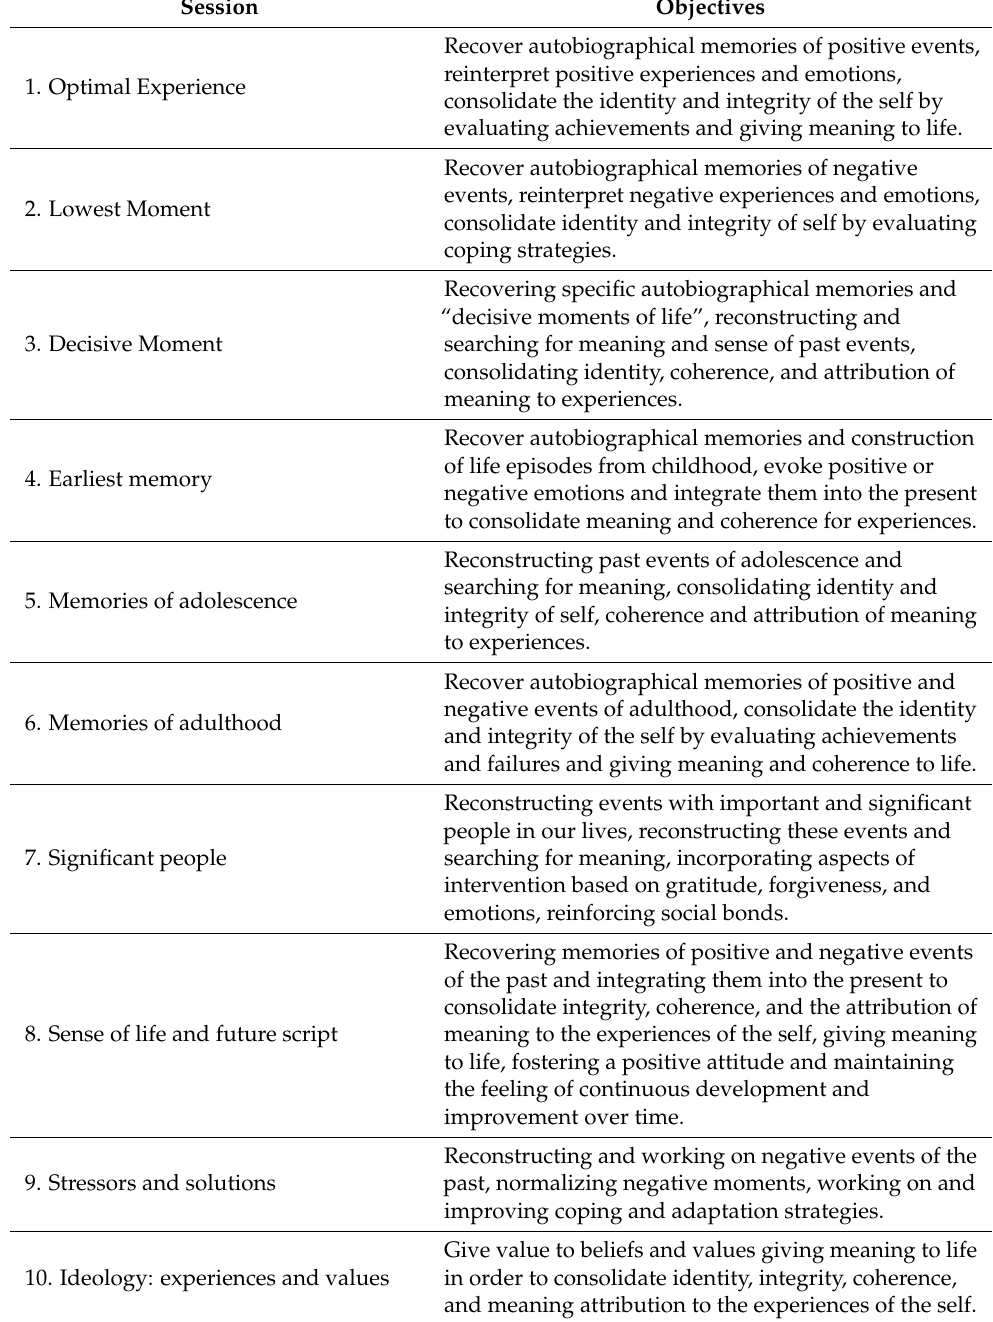
Table 2. Objectives of sessions in the reminiscence